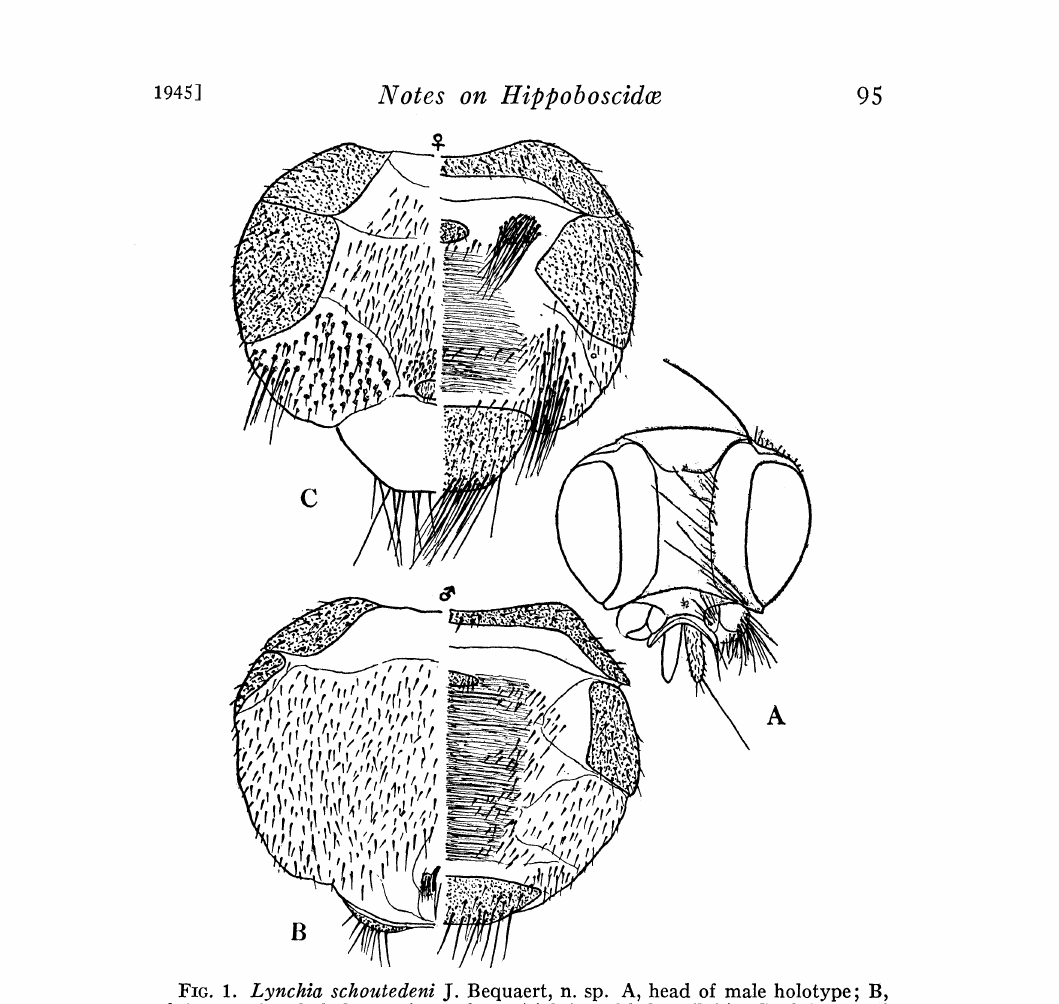
FIG. 1. Lynchia schoutedeni J. Bequaert, n. sp. A, head of male holotype; B, abdomen of male holotype from above (right) and below (left); C, abdomen of female paratype, Katwe, from above (right) and below